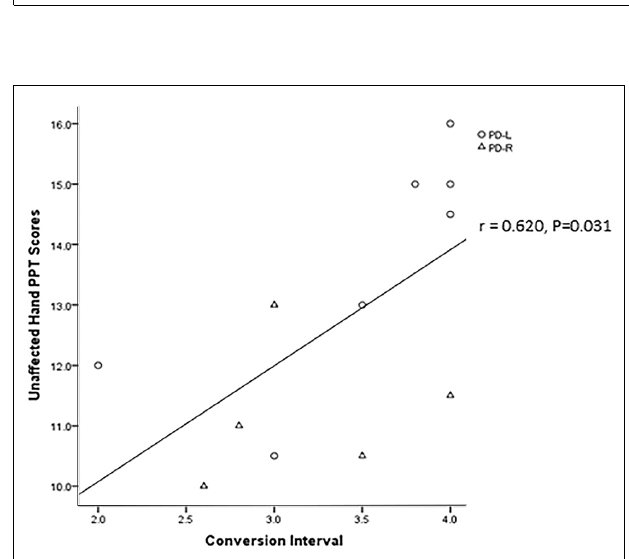
FIGURE 1 | ROC curves for symptomatic and asymptomatic hand PPT performance of PD-L and PD-R patients vs. normal controls. The symptomatic hand (dotted line) and asymptomatic hand (continuous line) pegboard dexterity for discriminating patients and normal controls. ROC, receiver operating characteristics; PPT, Purdue Pegboard Test; PD-L, left-onset Parkinson’s disease; PD-R, right-onset Parkinson’s disease; AUC, area under the ROC curve.